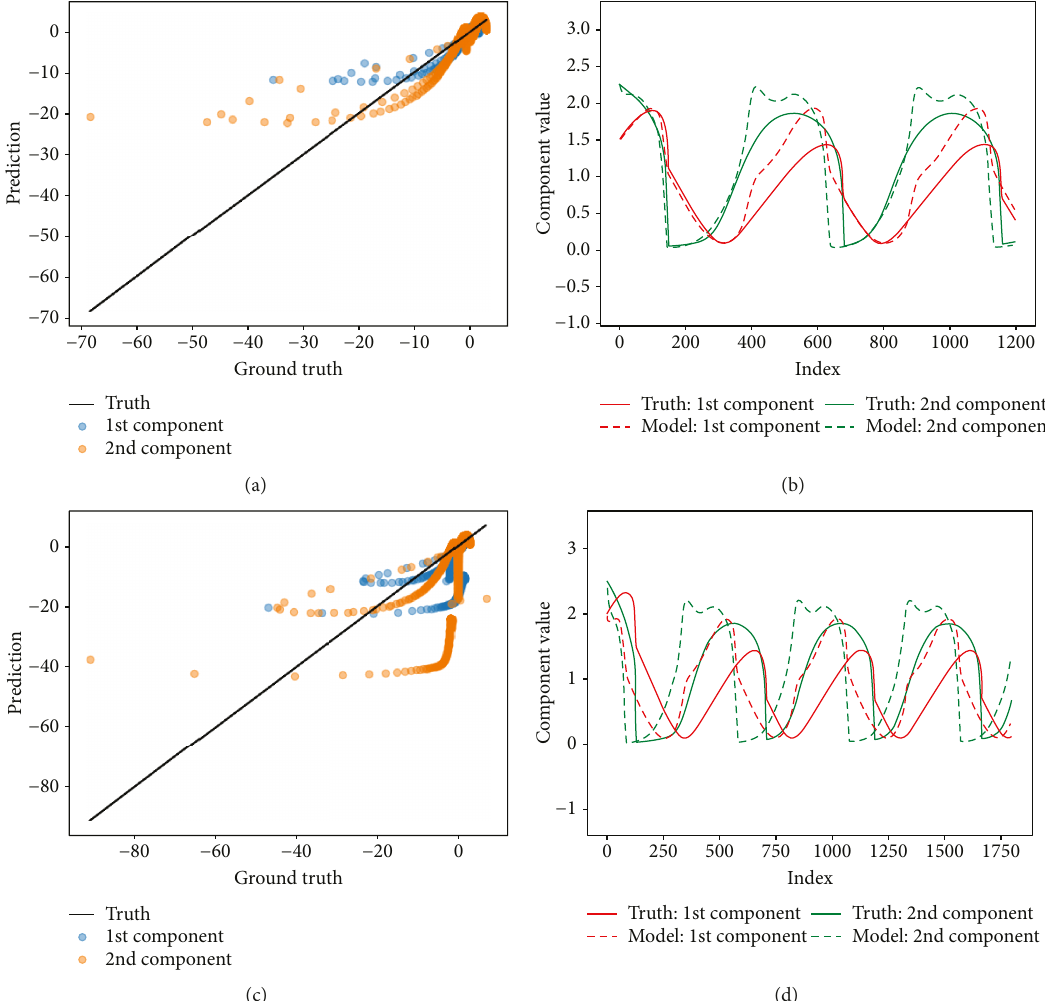
Figure 11: A priori and a posteriori result of SINDy on nonrational nonpolynomial case. (a, b) Training data. (c, d) Testing data. (a, c) A priori. (b, d) A